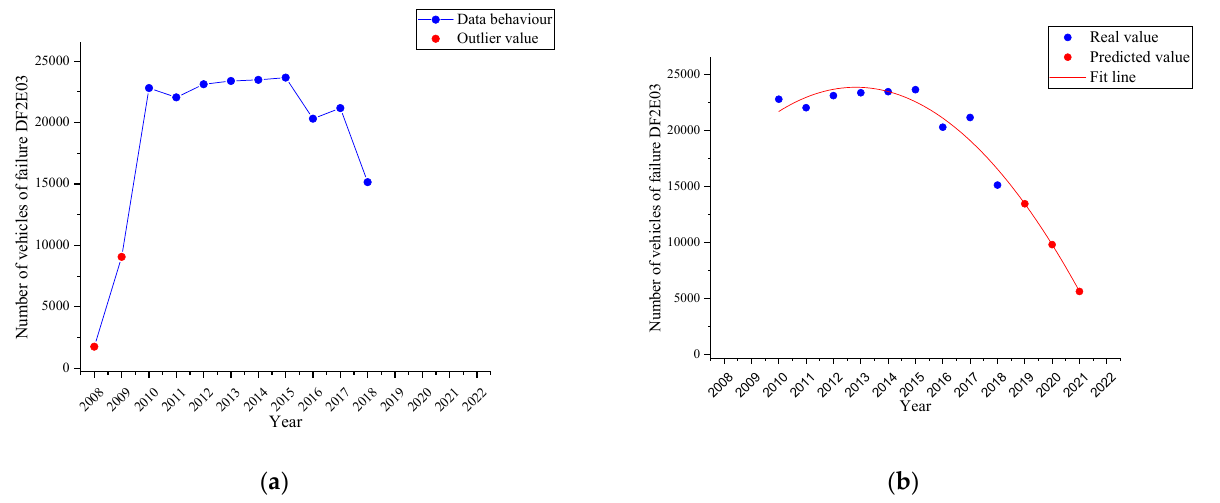
Figure 10. Failure trend is named as a braking imbalance on the 2nd axle (DF2A03). ( a ): Behaviour of the failure (blue line); ( b ): the time series with a quadratic trend (red line) and the forecast (red dots).